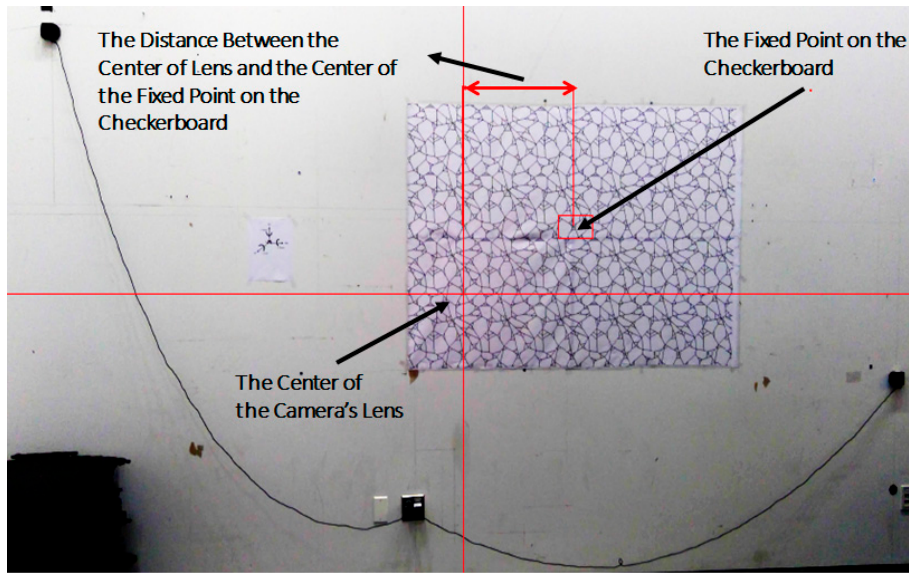
Figure 15. Distance between center of lens and center of the board installed on the wall.